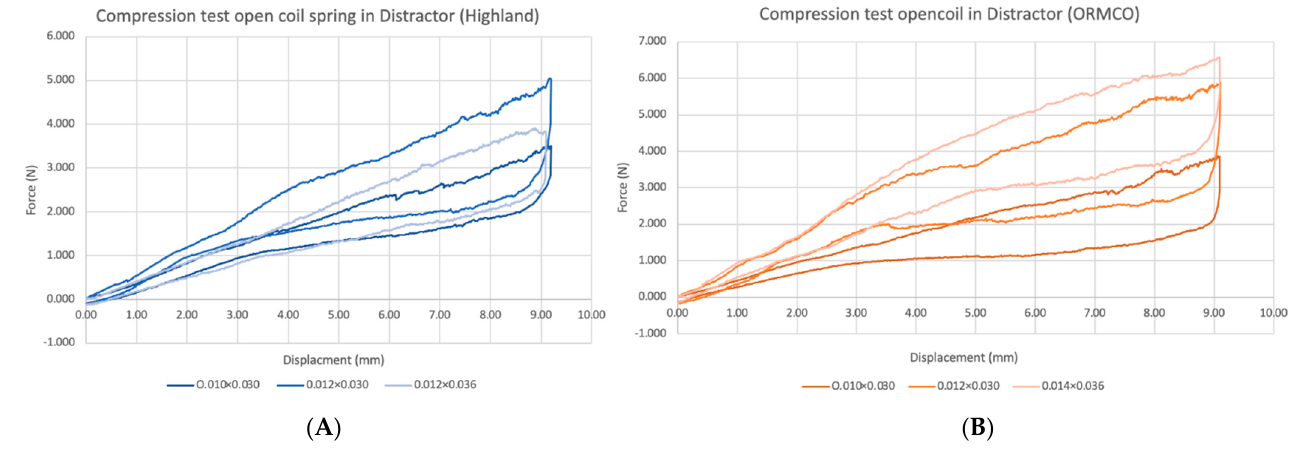
Figure 7. Load–displacement curves of NiTi open-coil springs of different manufacturers and di- mensions tested in the novel alveolar distractor. ( A ) The Highland group; ( B ) the ORMCO